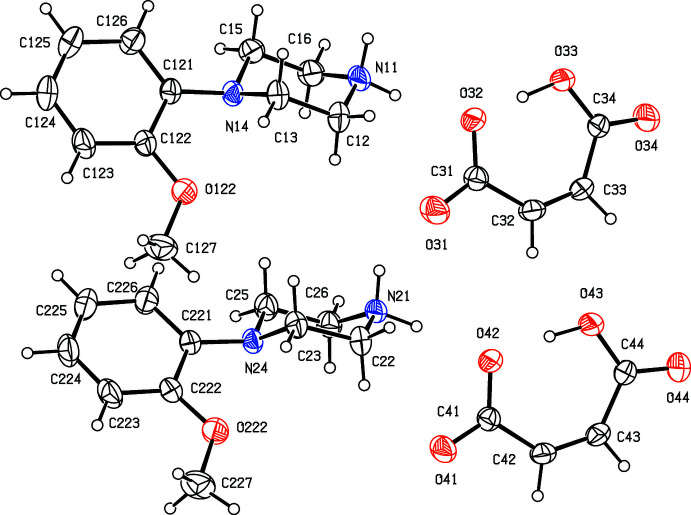
The independent components of compound (XIII) showing the atom-labelling scheme. Displacement ellipsoids are drawn at the 30% probability level.